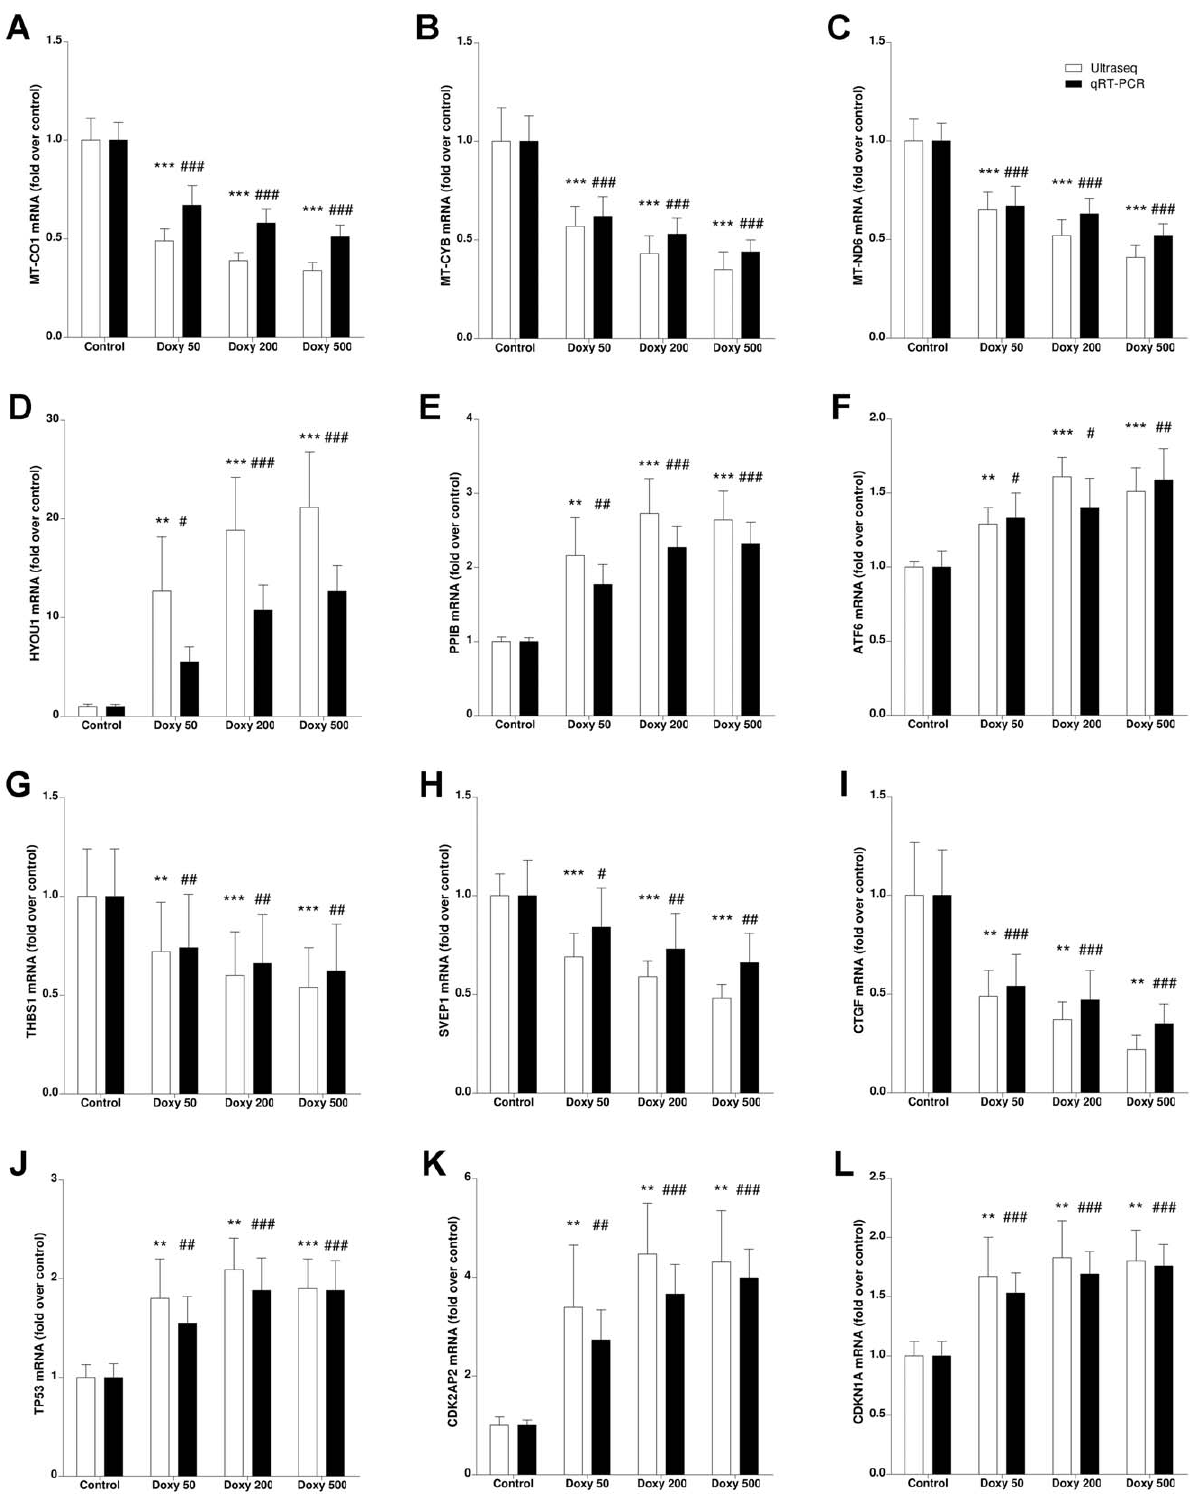
Figure 6. Gene expression quantification by ultrasequencing (open bars) and qRT-PCR (solid bars) for several sample genes involved in different pathways such as mitochondrial genes (A-C), endoplasmic reticulum stress response (D-F), members of the integrin family (G-I), and genes related with the cell cycle (J-L). Bars represent fold increase (or decrease) with respect to untreated controls 6 SEM for 10 independent samples. Statistically significant differences with untreated controls are represented by asterisks (for ultrasequencing data) or the pound sign (for qRT-PCR). **: p , 0.01; ***: p , 0.001; # : p , 0.05; ## : p , 0.01; ### : p , 0.001.